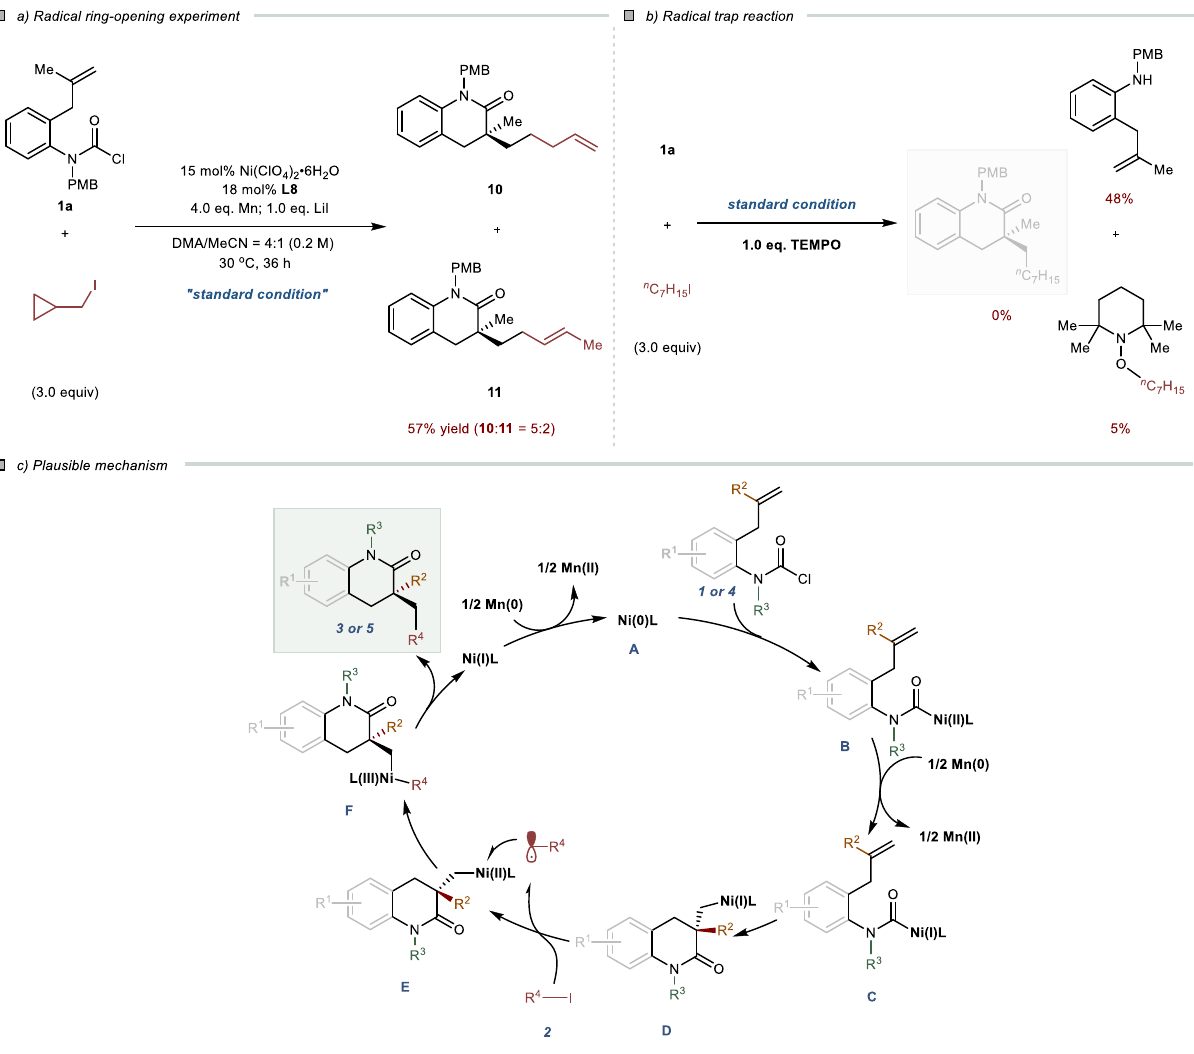
Fig.7|Mechanisticexperiment.a Radicalring-openingexperiment.Theyieldwas reported as isolated yield. b Radical trap reaction using TEMPO as radical